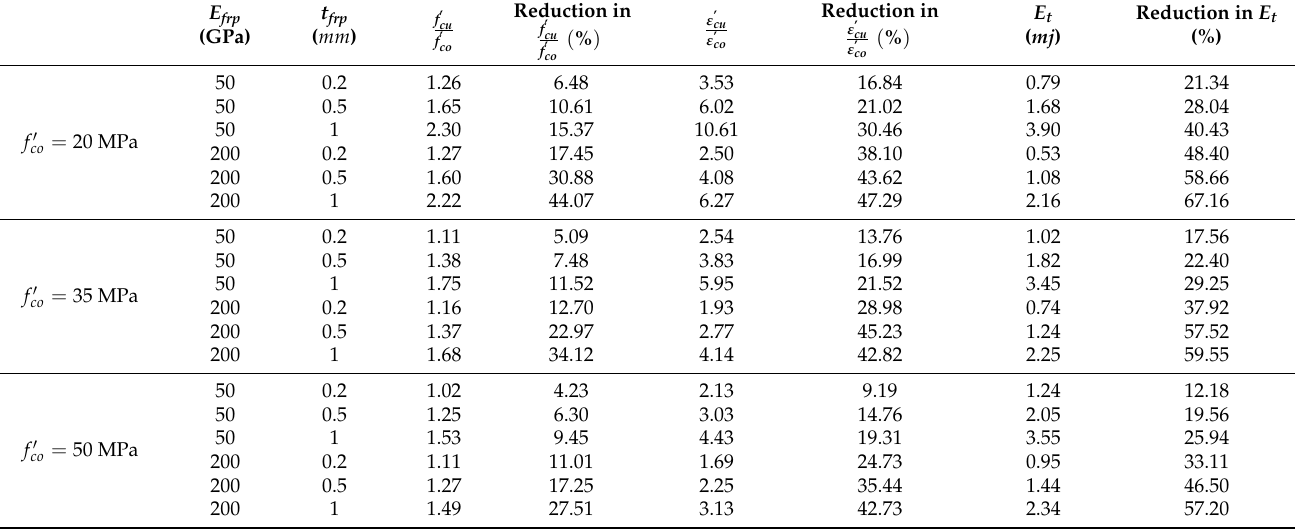
Table A5. FEM results for θ = 15 ◦